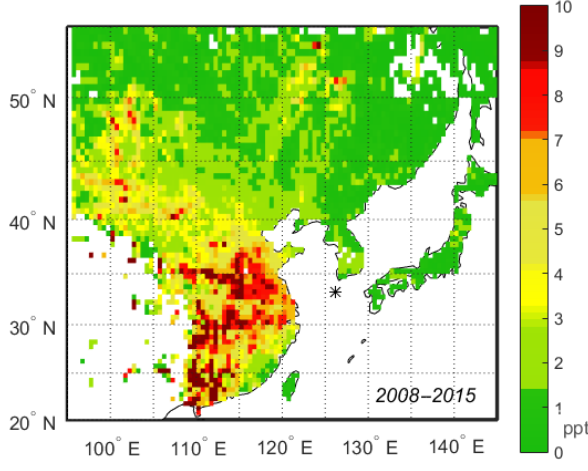
Figure 2. Distribution of potential source regions calculated from trajectory statistics for enhancement data of CCl 4 observed from 2008 to 2015. The color code (in ppt) denotes a residence- time-weighted mean concentration for each grid cell. The resulting map of potential source areas for CCl 4 shows that emission sources are widely distributed over China. The site of Gosan station is indi- cated by an asterisk ( ∗